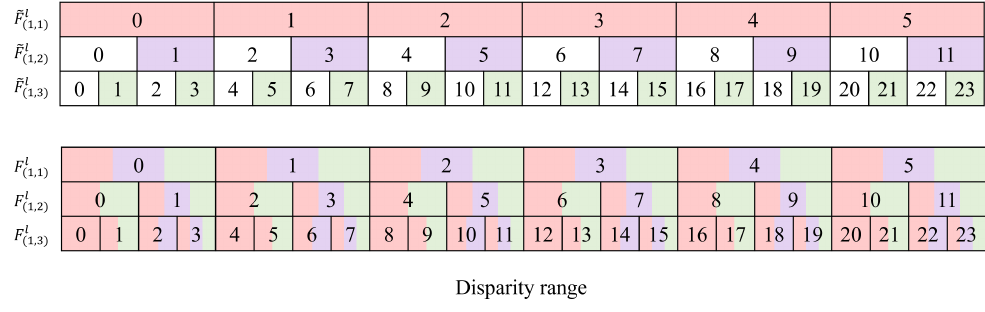
Figure 6. Details of multi-scale features before and after cross-scale fusion in the disparity